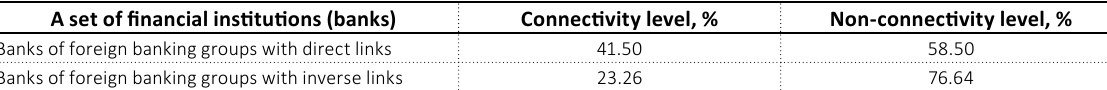
Table 4. Summary of bank connectivity data